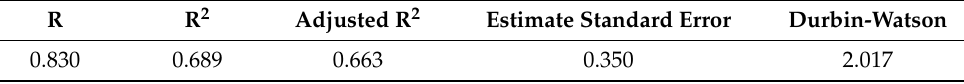
Table 5. R 2 values, estimate standard error, and Durbin-Watson statistic for the regression model.